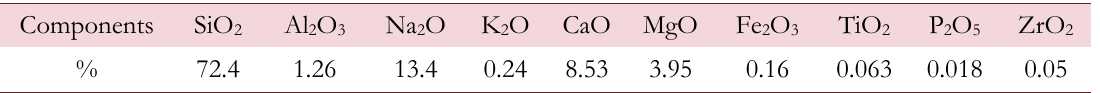
Table 1: Chemical composition of soda-lime-silica glass [31].